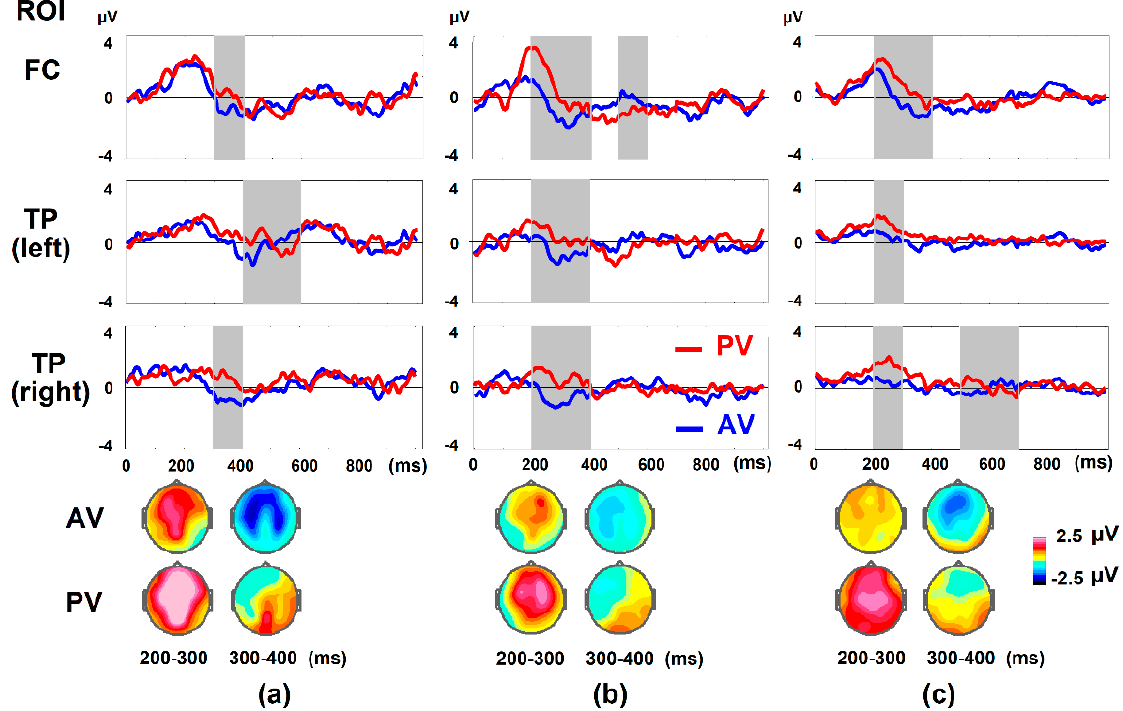
Figure 3. Average ERP amplitudes in the frontocentral (FC) and temporoparietal (TP left and TP right) ROIs from the beginning of NP2 in sentences with active (AV—blue) and passive (PV—red) voice. Time in ms is on the x-axis, and amplitude in µV is on the y-axis. Topography of ERP averaged for AV and PV in 100 ms TWs: 200–300 and 300–400 ms. ( a )—four-year-old children ( n = 13), ( b )— five-year-old children ( n = 14), ( c )—six-year-old children ( n = 16). The intervals of significant differ- ences in the mean ERP amplitudes p < 0.05 are highlighted in gray.